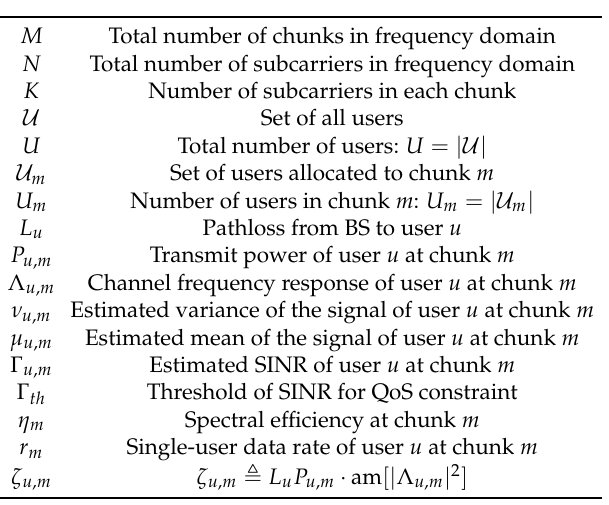
Table 1. List of primary